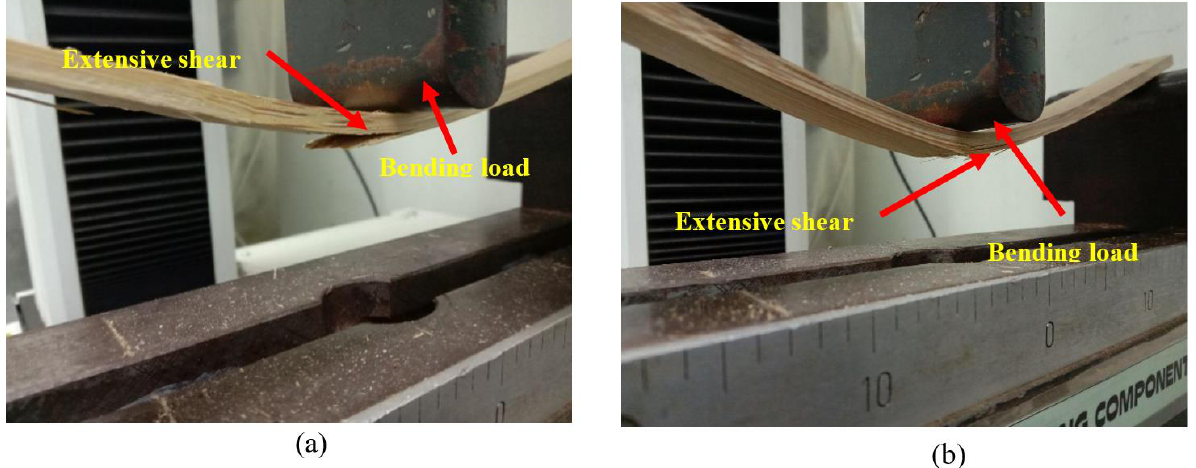
Figure 9. Failure mode of strips from four bamboo species loaded in static bending: ( a ) brittle shear tension mode, ( b ) splintering tension mode. tension mode, ( b ) splintering tension